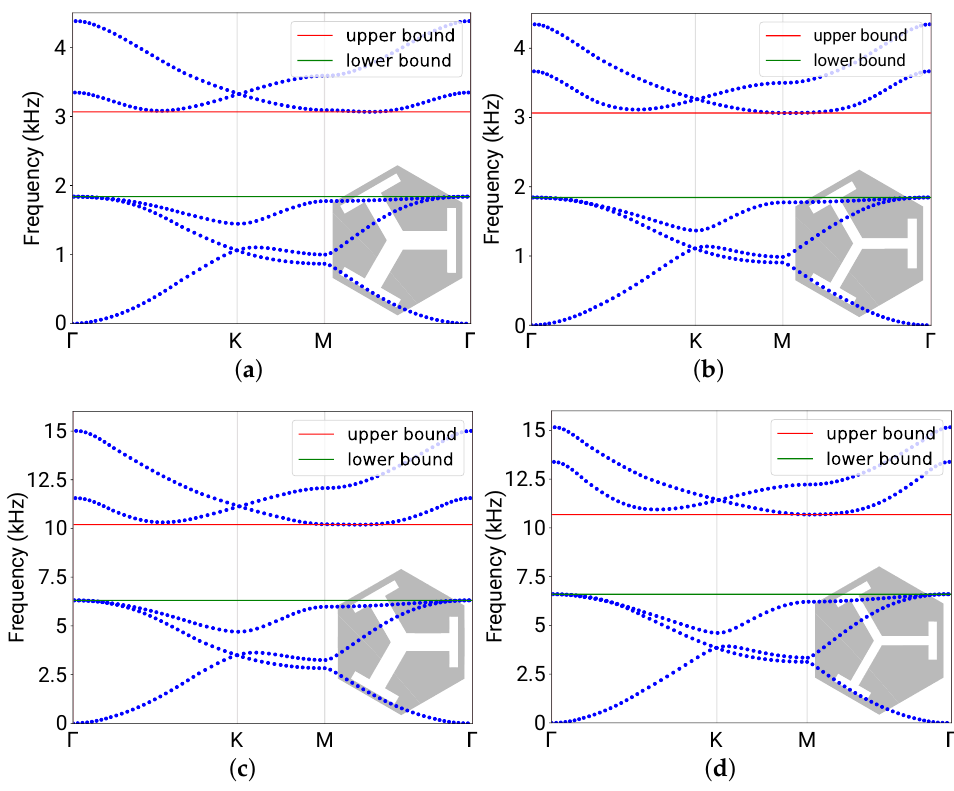
Figure 10. Band structures for the phononic plates considered in the case studies. ( a ) The prepared (ground-truth) phononic plate in Case 2. ( b ) The DNN-predicted phononic plate in Case 2. ( c ) The prepared (ground-truth) phononic plate in Case 3. ( d ) The DNN-predicted phononic plate in Case